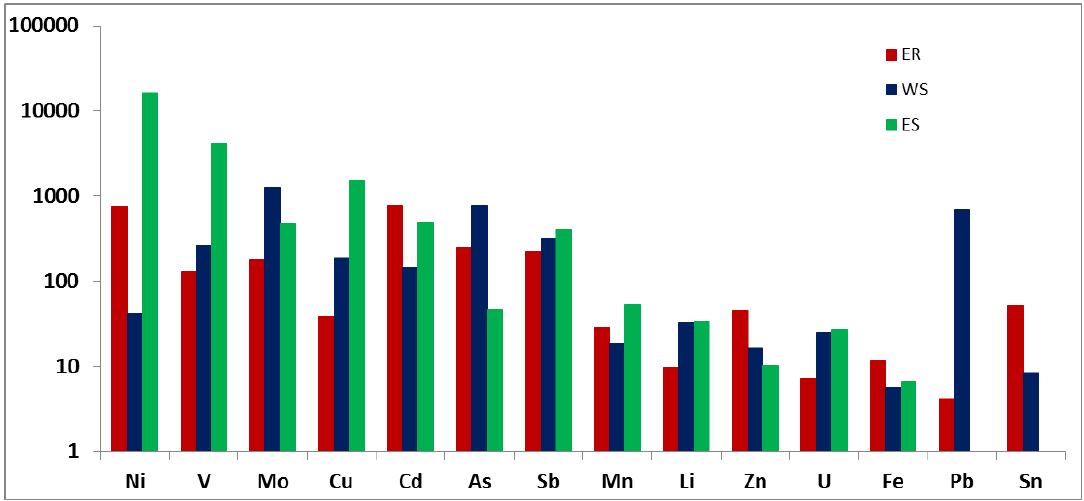
Figure 5. Enrichment factors of elements.